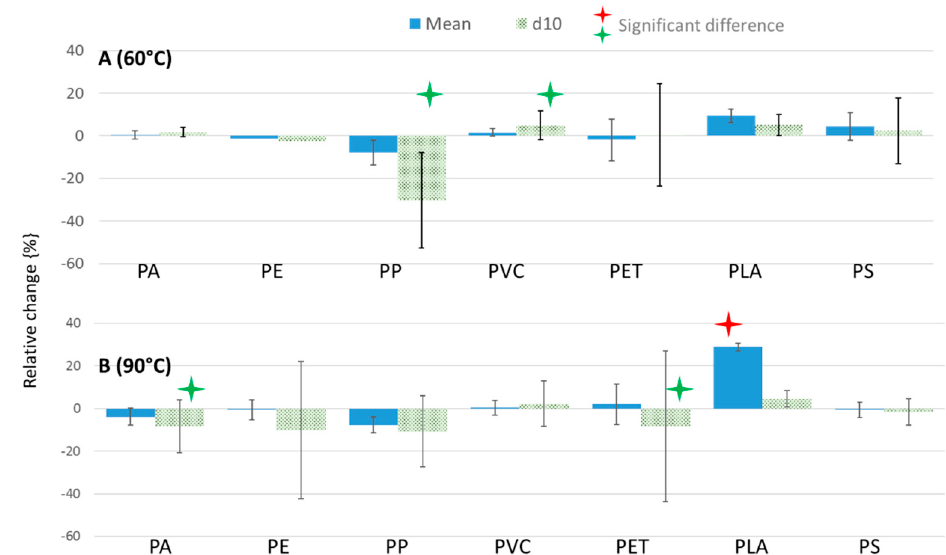
Figure 7. Relative particle size changes after temperature treatments compared to controls (for weighted average sizes and 10th percentiles (d10)). The error bars represent the standard deviations. ( A ): 60 °C for 24 h, ( B ): 90 °C for 20 min. The red and green stars indicate statistical significance for the entire distribution, as well as d10, respectively.